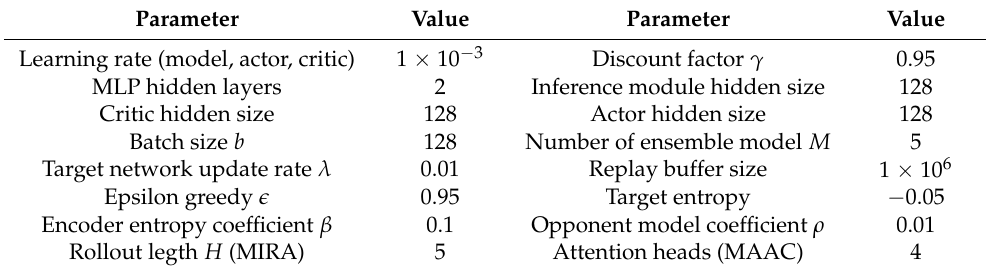
Table 1. Hyperparameters